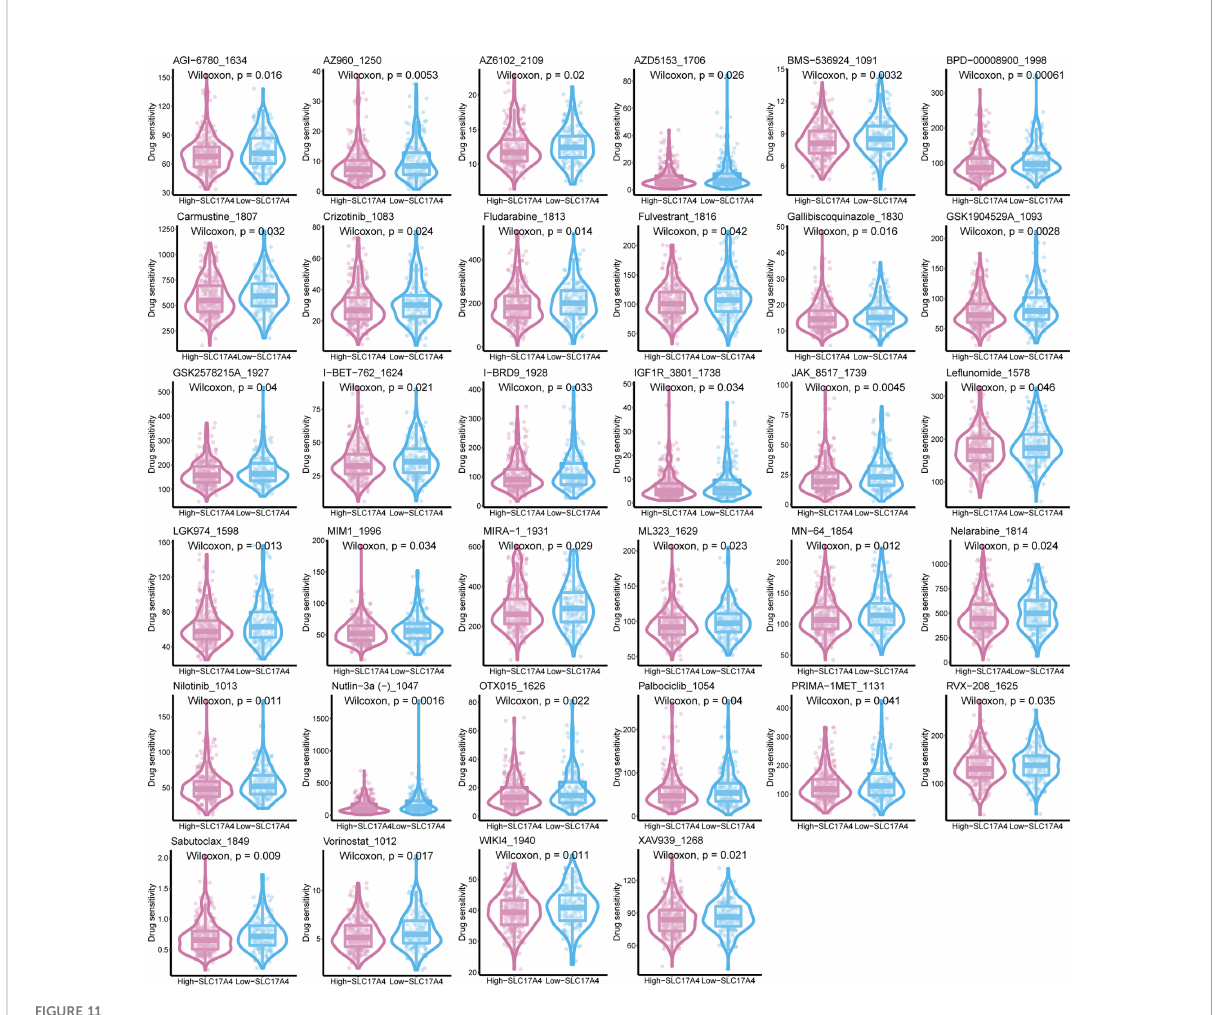
FIGURE 11 The IC50 of 38 chemotherapy drugs in PCa cells was estimated in SLC17A4 groups utilizing the GDSC